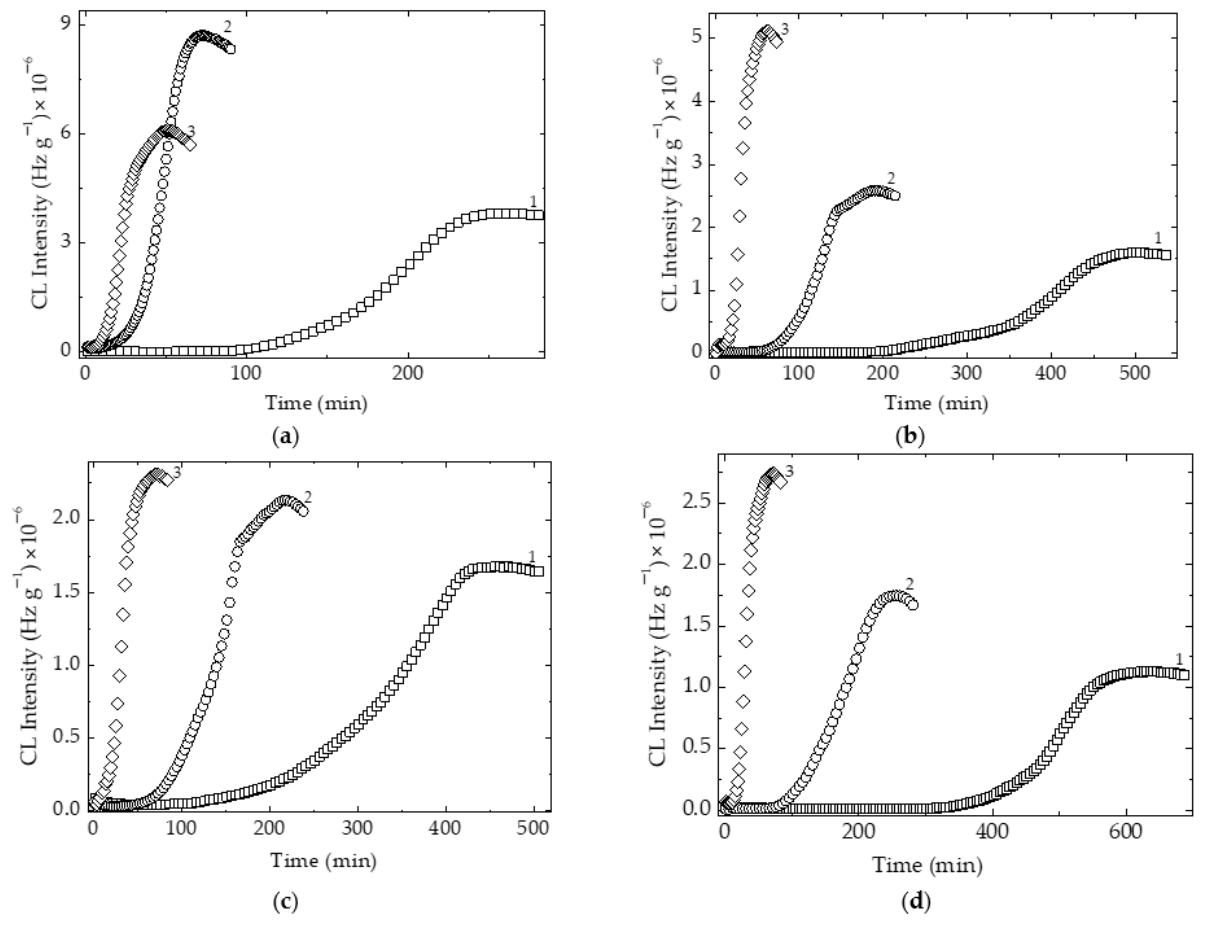
Figure 7. The isothermal CL spectra recorded on SIS samples modified by various graphene loadings. ( a ) free of additive; ( b ) graphene 1 wt%; ( c ) graphene 2 wt%; ( d ) graphene 3 wt%; Testing temperatures: (1) 130 °C; (2) 140 °C; (3) 150 °C. Table 2. Activation energies required for the oxidation of SIS improved with various amounts of reduced graphene